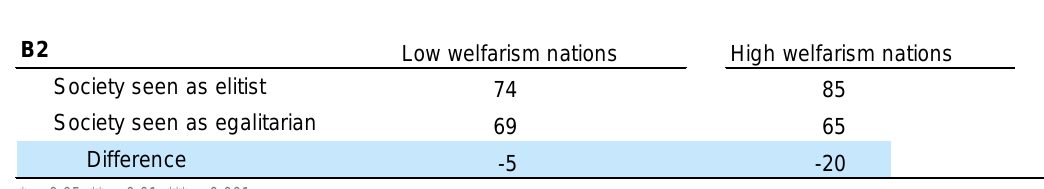
Figure A12. Sensitivity with a second interaction (perceived inequality). Additional national-level controls involving a second cross-level interaction make little difference to the key results. Influences on attitudes toward redistribution with cross-level interactions involving welfarism and income and involving welfarism and perceptions of societal inequality (diagram question). Multilevel estimates, metric coefficients (Panel A) and predicted values (Panel B).